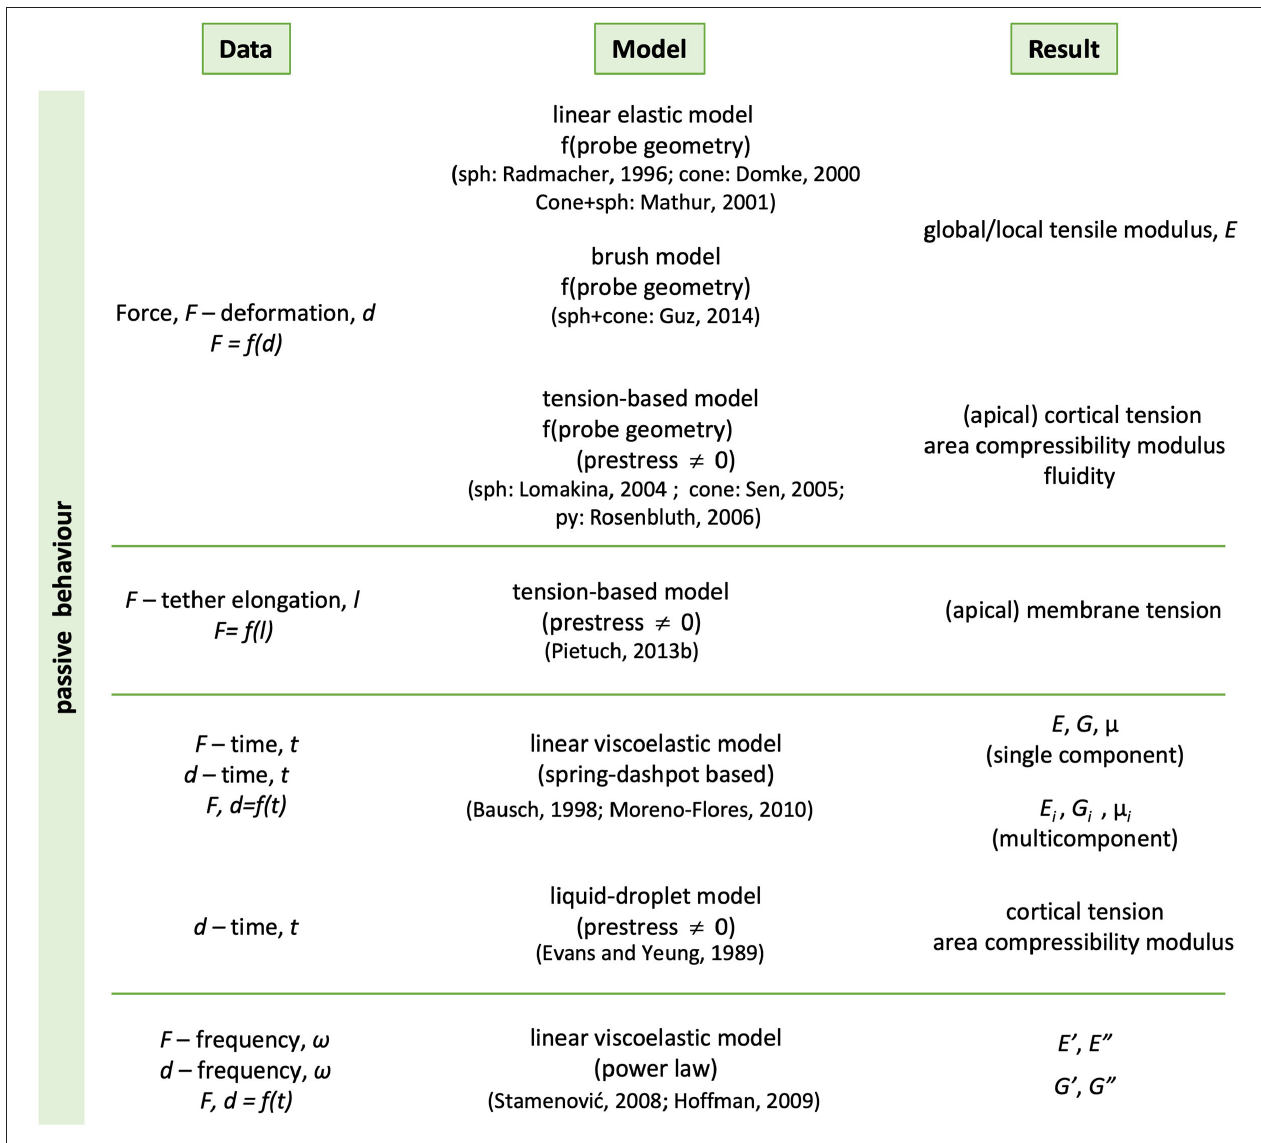
FIGURE 10 | Summary of the phenomenological descriptions most commonly used to analyse experimental data of living cells. The methods are traditional of Contact Mechanics and used to characterize at least the passive behavior of materials. Representative references are included in brackets. sph, cone, py stand for spherical, conical and pyramidal indenter,